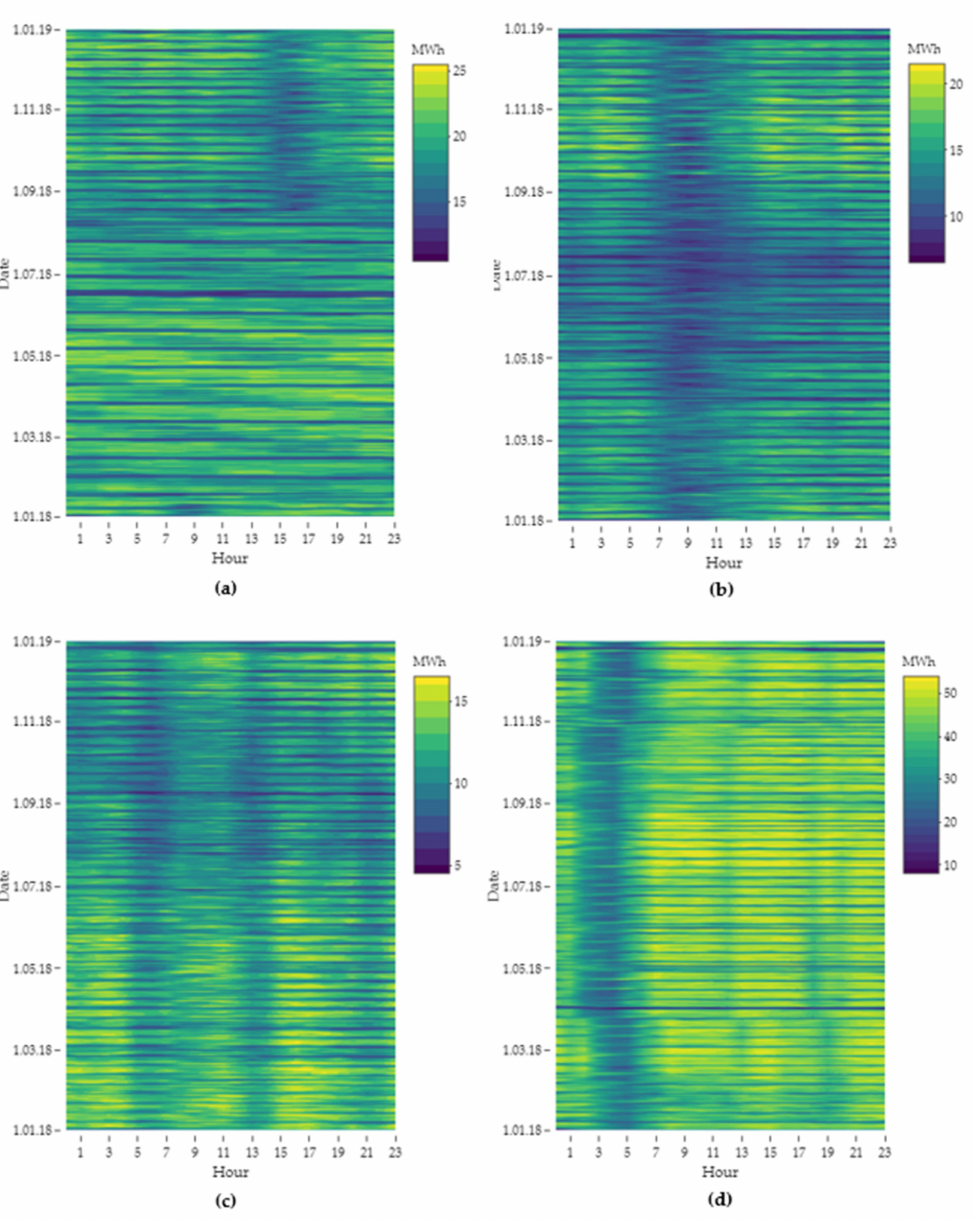
Figure 3. Annual course of hourly electricity consumption for the analyzed case study: ( a ) M1, ( b ) M2, ( c ) M3 and ( d ) M4. Source: own